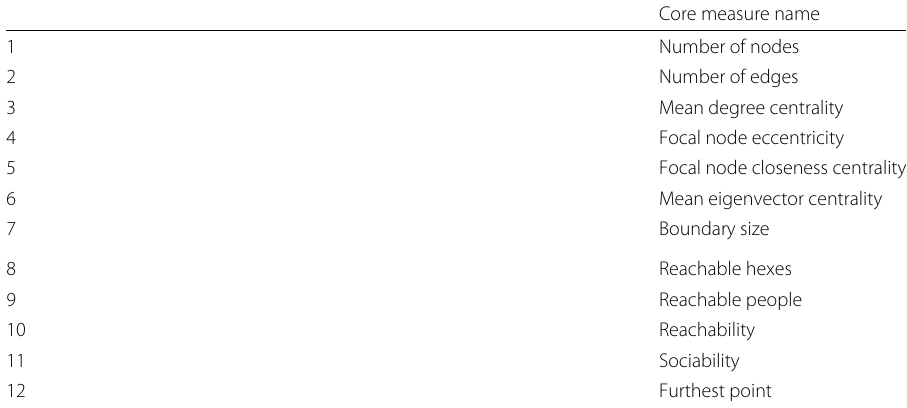
Table 3 Table summarizing the collection of core (network plus geotemporal) measures applied to each travel pattern subnetwork for each